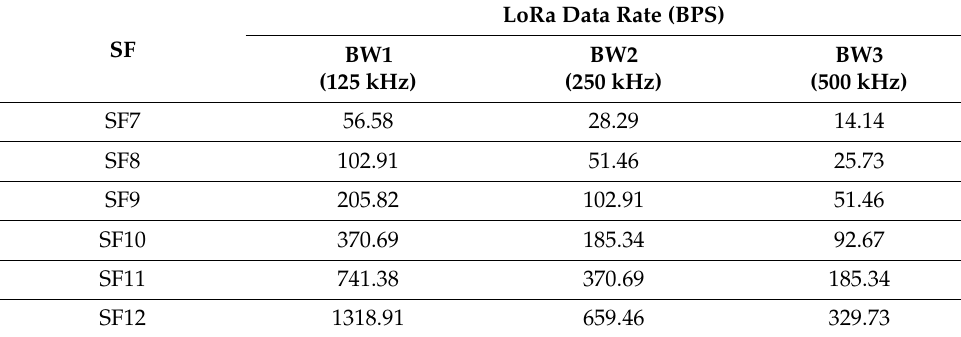
Table 10. Time on Air (ToA) (ms) at CR1.